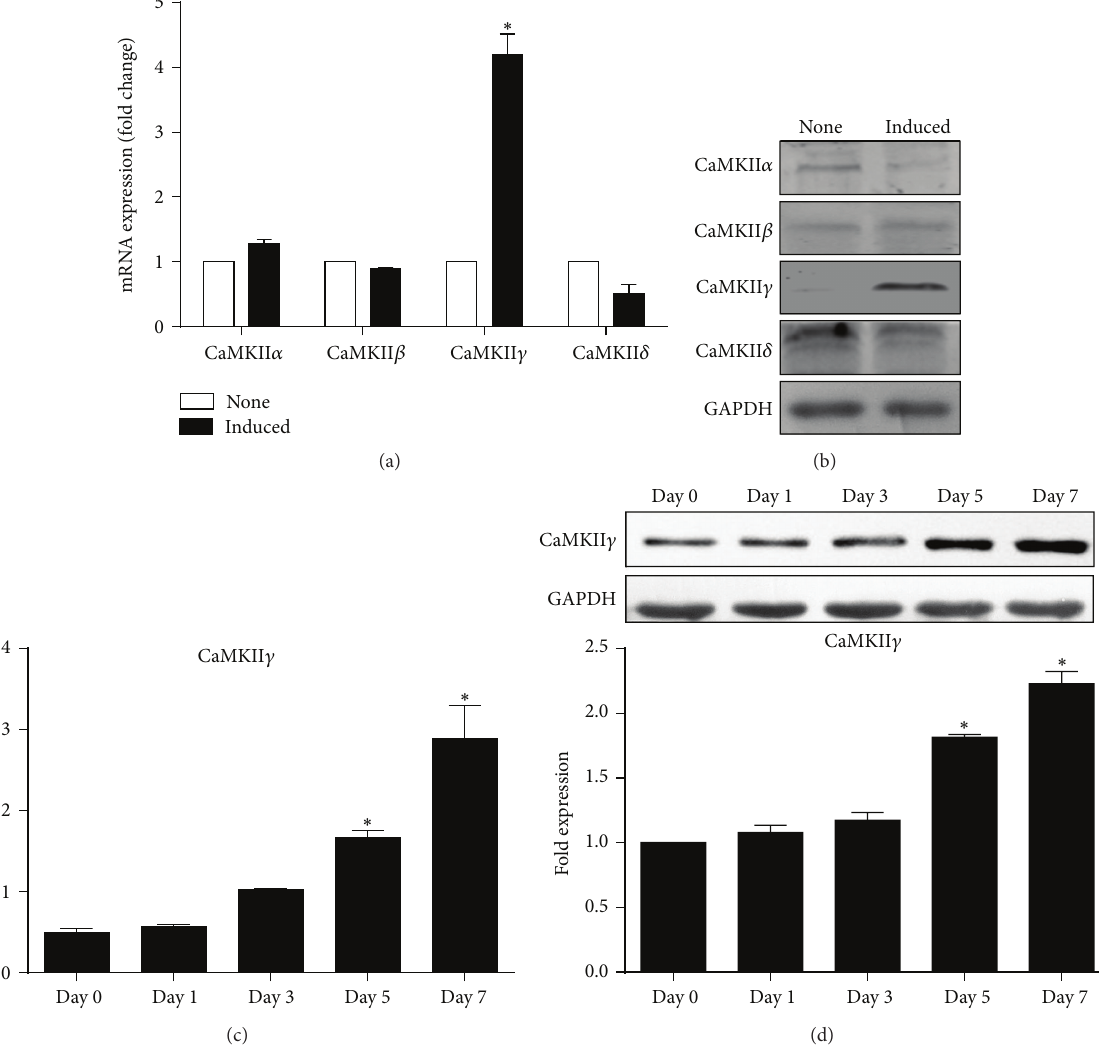
Figure 2: Expression of CaMKII isoforms in hASCs subjected to combined treatment with TGF- 𝛽 1 and BMP4 for 7 days. mRNA (a) and protein (b) expressions of CaMKII isoforms after smooth muscle differentiation of hASCs. (c) qRT-PCR analysis of CaMKII 𝛾 expression at 1, 3, 5, and 7 days, respectively. (d) Expression of CaMKII 𝛾 detected by western blot at 1, 3, 5, and 7 days of stimulation. ∗ 𝑃 < 0.05 when (a) versus none, (b) versus day 0, and (d) versus day